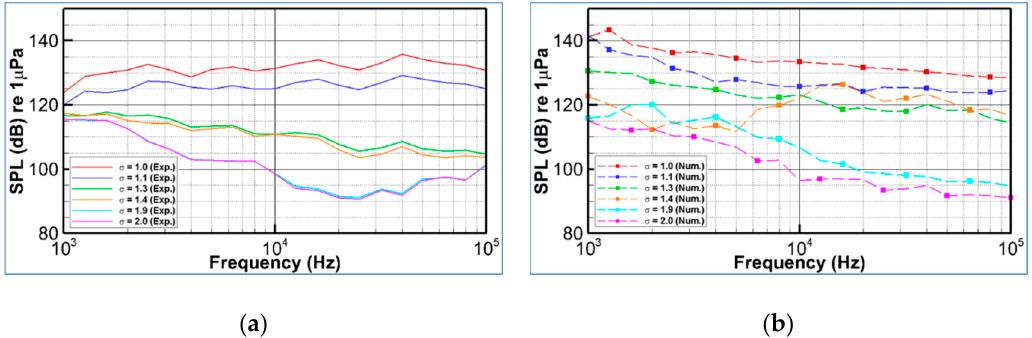
Figure 29. Comparison of one-third octave band spectrum between numerical and experimental results according to cavitation number: ( a ) measured spectrum and ( b ) predicted spectrum.